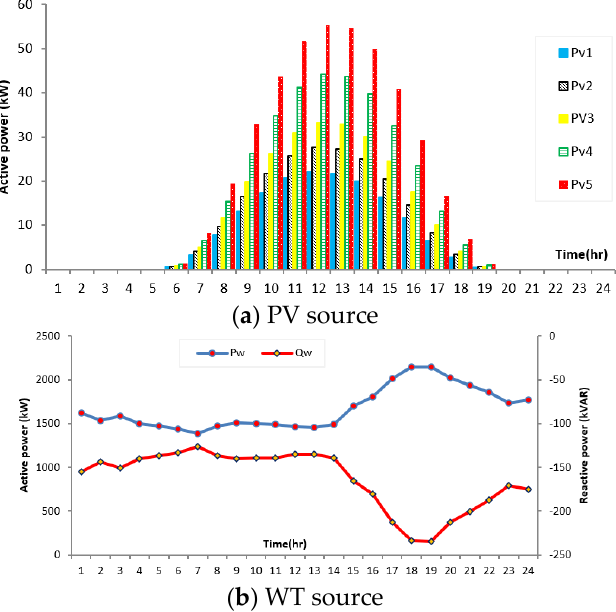
Figure 17. Hourly produced active and reactive power from PV and WT sources for the second MG.